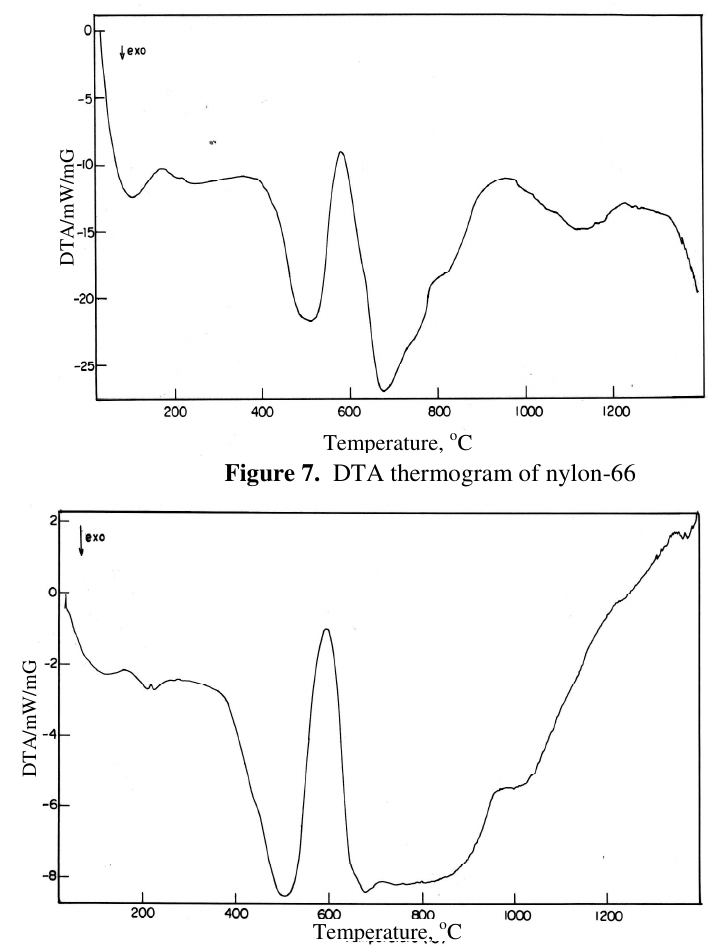
Figure 8. DTA thermogram of GF